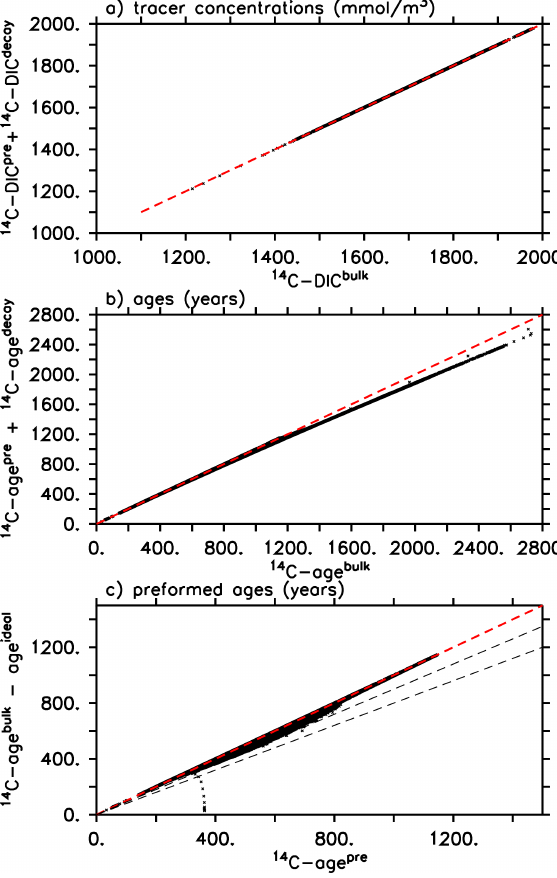
Figure 4. Scatter plots (a) of 14 C-DIC tracer concentrations vs. the sum of 14 C-DIC pre and 14 C-DIC decay tracer concentrations and (b) bulk 14 C-age vs. the sum of ages computed from 14 C-DIC pre- formed and decay tracers. Note that a few grid cells with 14 C-DIC concentrations below about 1300mmolm − 3 and bulk ages above about 2600yr are not fully in steady state after the 2500yr run time of this model experiment. We ignore these grid cells in the discus- sion. (c) Comparison of ages derived from the 14 C-DIC preformed tracer and by difference of the bulk 14 C-DIC tracer and the ideal age tracer. Red dashed line is the 1 : 1 line, dashed grey lines indicate − 10 and − 20%